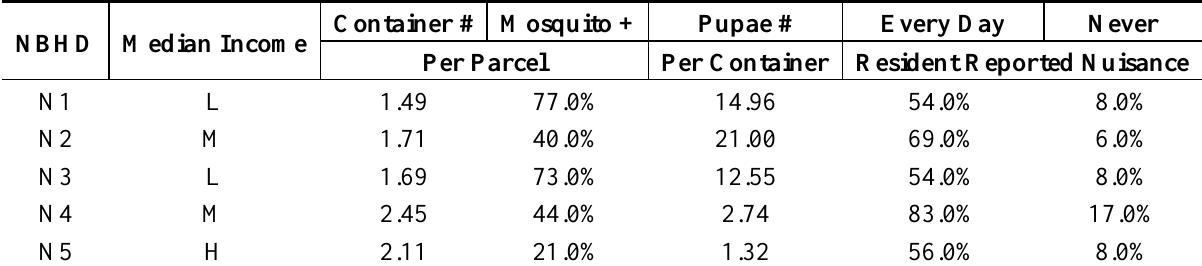
Table 3. Neighborhood indicators, calculated across all sampling